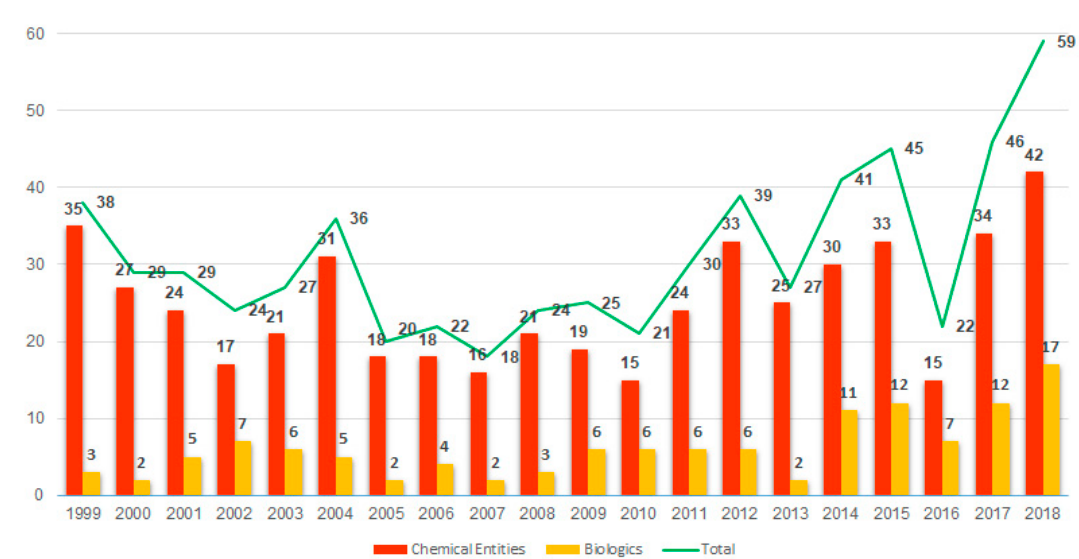
Figure 1. New chemical entities and biologics approved by the FDA in the last two decades [1,4,5].